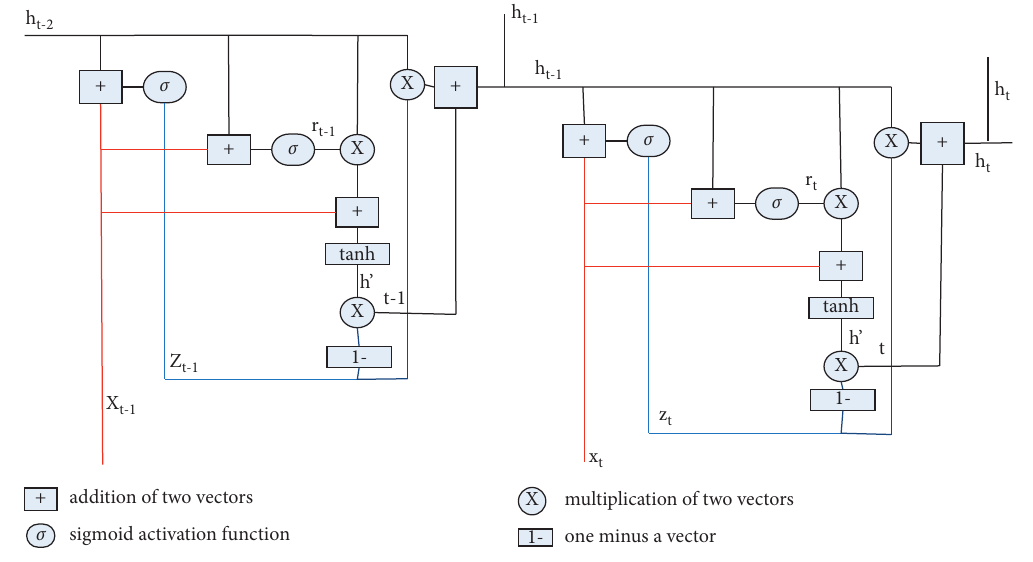
Figure 2: Gated recurrent unit neural